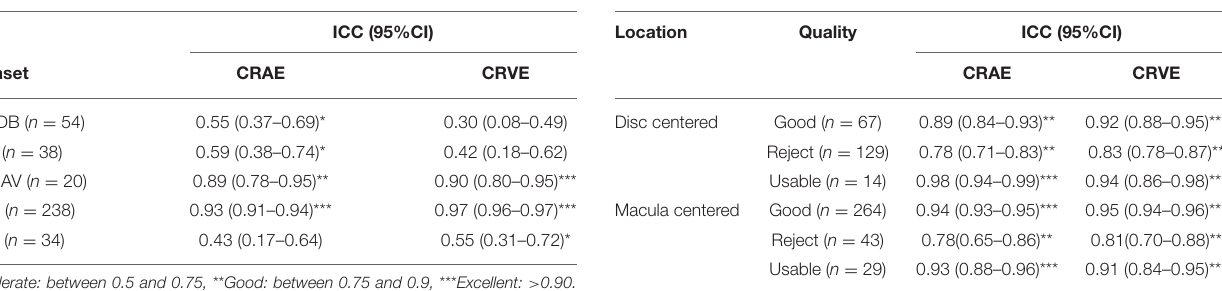
TABLE 5A | Agreement estimates of measurements in the Standard zone on photographs taken repeatedly under similar conditions.